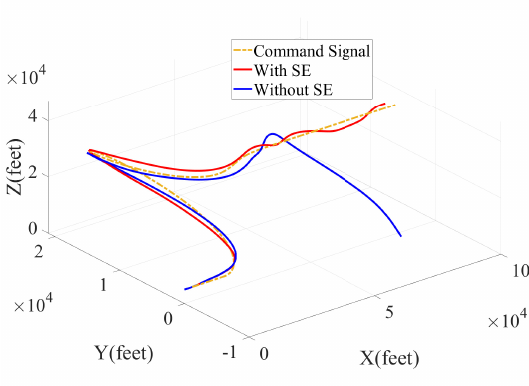
Figure 15. Trajectory in 3-dimensional space.